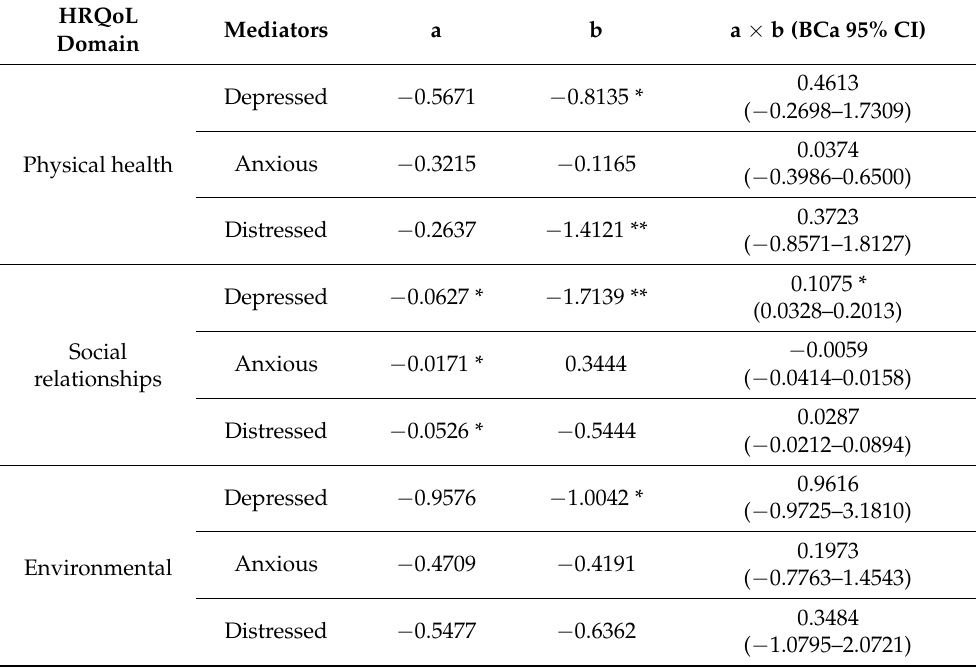
Table 8. Mediating roles in HRQoL